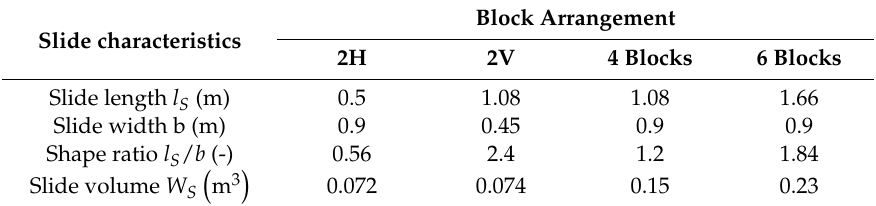
Table 2. Slide characteristics in the model setup for di ff erent block setups (model scale).